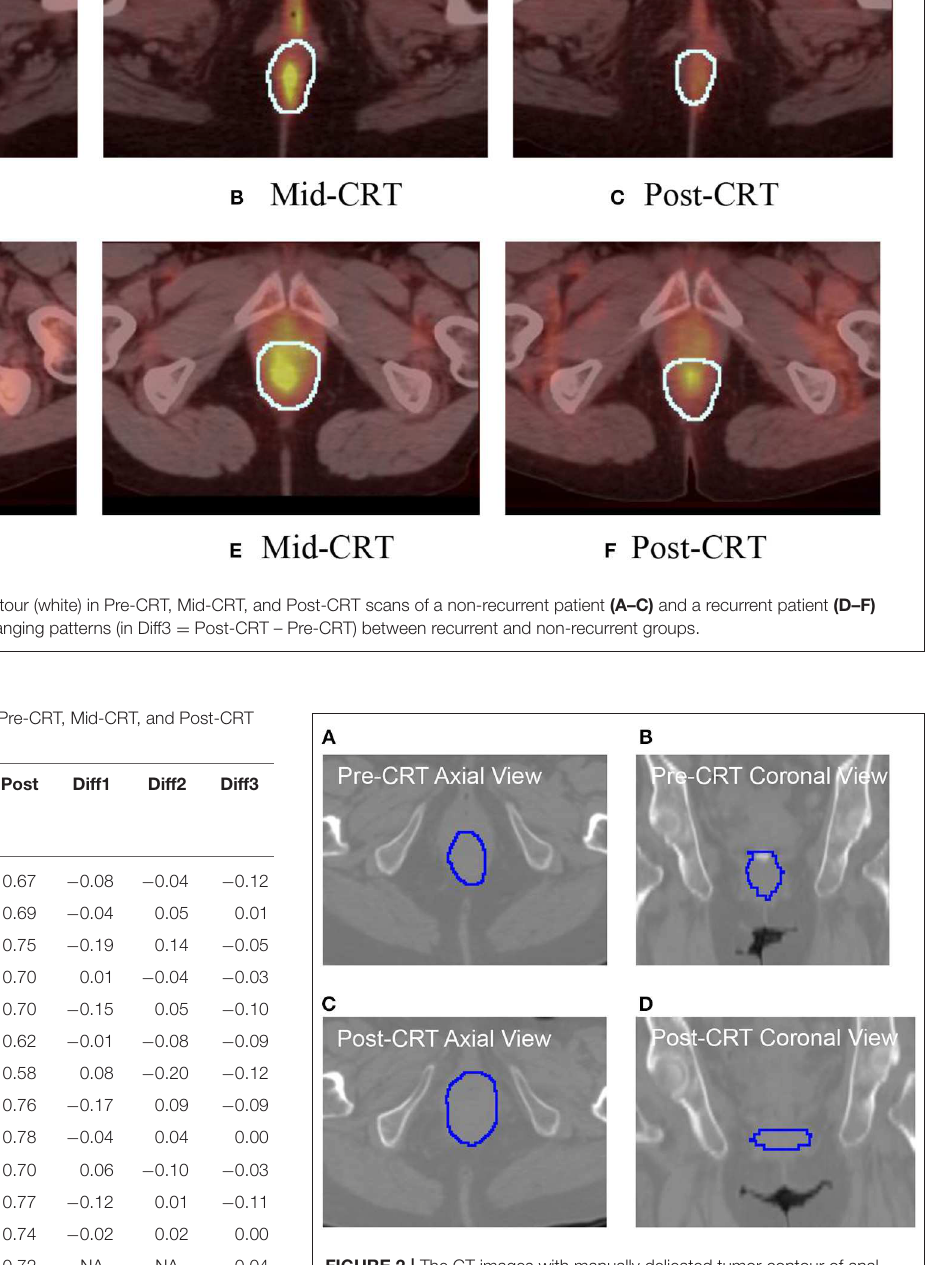
FIGURE 2 | The CT images with manually delieated tumor contour of anal cancer patient with no tumor recurrence. The tumor regressed in coronal directions (B) vs. (D) . However, it progressed in axial direction (A) vs. (C) . The roundness of this tumor was changed from 0.70 (Pre-CRT) to 0.58 (Post-CRT).